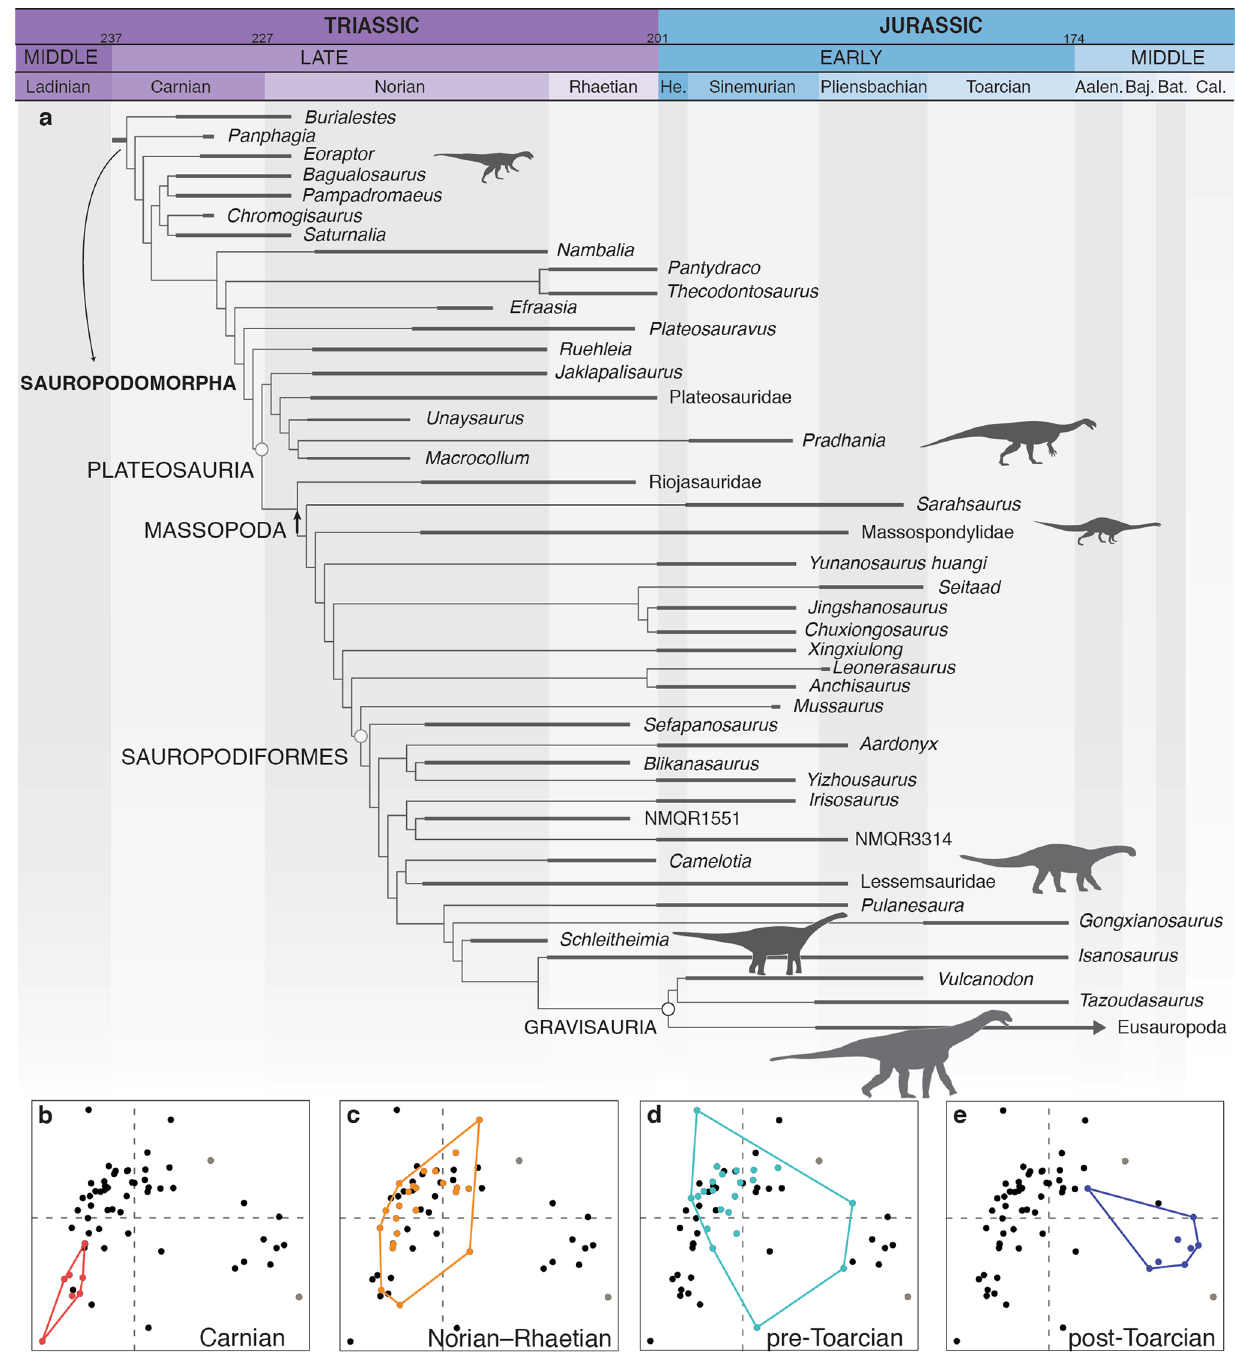
Figure 1. Morphospaces and diversity of Sauropodomorpha during the Triassic-Early Jurassic. ( a ) Randomly selected, time calibrated MPT and morphospace occupation of Sauropodomorpha during ( b ) Carnian, ( c ) Norian-Rhaetian, ( d ) pre-Toarcian, and ( e ) post-Toarcian periods. Each plot shows the first two principal coordinate axes, with a variance of 9.82% (PCo 1, x axis) and 3.90% (PCo 2, y axis) (see Fig. 2b for more details about morphospace